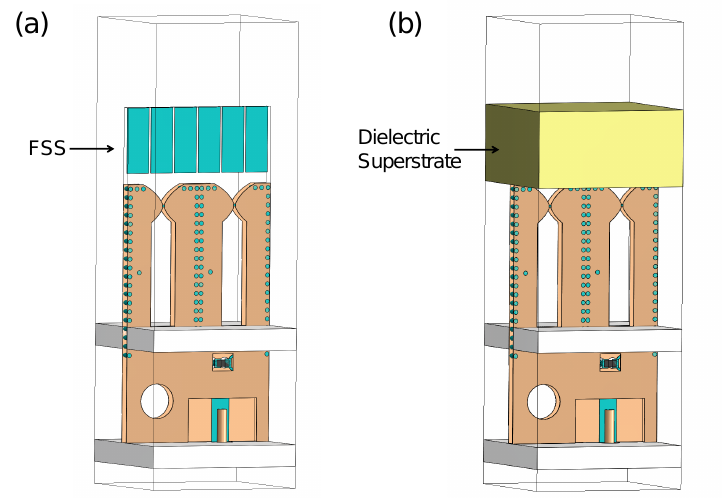
Figure 5. Unit cell of the proposed TCDA with ( a ) FSS and ( b ) equivalent dielectric superstrate.